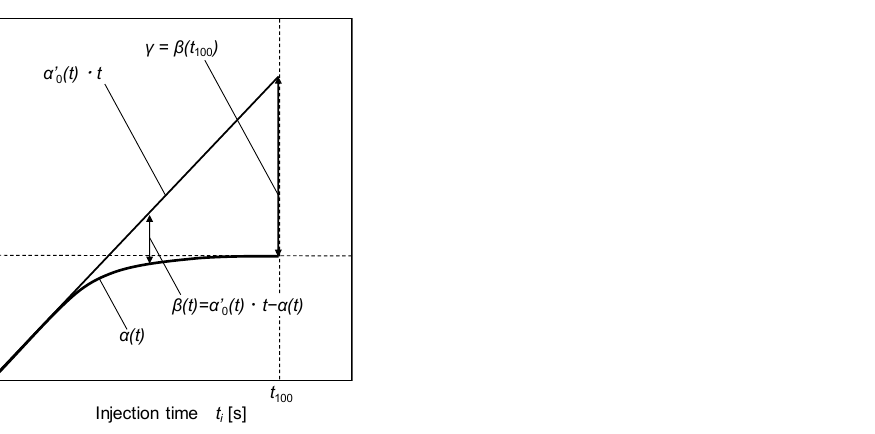
Figure 6. Coating thickness on a red line in Figure 5. Figure 7 shows fluorescent and pseudo-color images of the droplet on the formed coating surface. Other conditions are the same as in Figure 5. Figure 8 represents the time change in the cross-sectional thickness of the droplet. It was confirmed that both ends of the droplet show a high value when the droplet adheres to the coating at T D = 1/90 s. However, the center part of the droplet did not become thick after adhesion. The spike- shaped part seen in the T D = 3/90 s data indicated the presence of air bubbles. The coating thickness before ( T D = 0/90 s) and after ( T D = 6/90 s) the droplet adhesion was compared. The coating thickness did not change in the range where the droplet adhered (70 < X < 170). However, the coating thickness increased in the range where the droplet did not adhere (1 < X < 70, 170 < X < 205). This result shows that the adherent droplet spread around and integrated with the coating. Using the fluorescence method, it is possible to analyze the change in the coating thickness in a short time (within minutes) by examining the fluorescence intensity distribution in the cross-section. Figure 7. Fluorescent and pseudo-color images of the paint droplet. 0